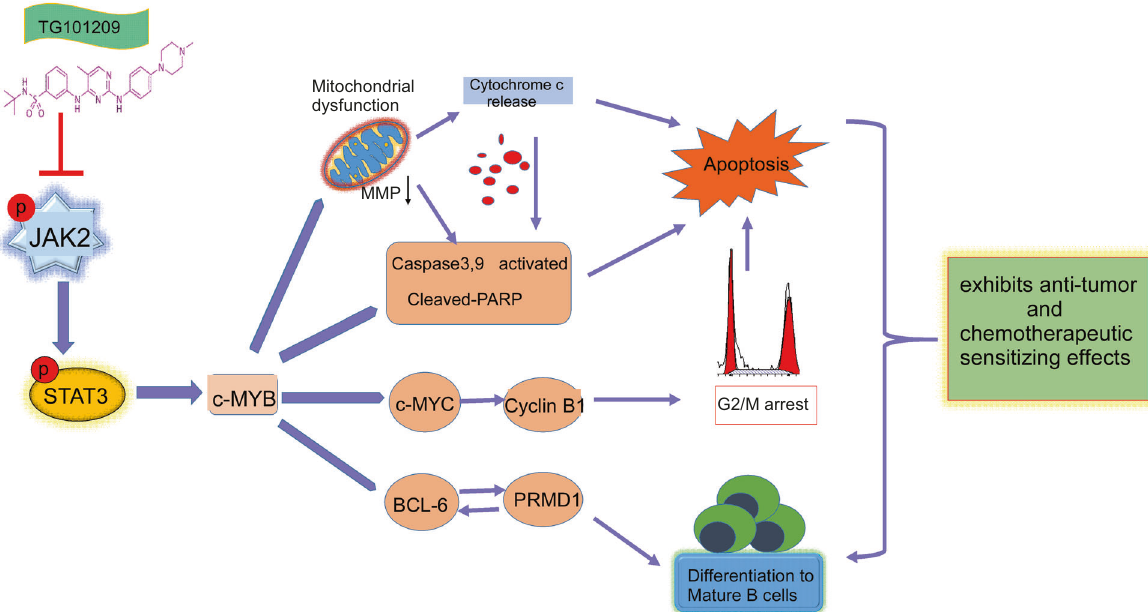
Fig. 7 Proposed model summarizing the results. TG101209 exhibits the activity of anti-tumor and chemotherapeutic sensibilizating effect on Burkitt lymphoma cells by inhibiting the JAK2/STAT3/c-MYB signaling